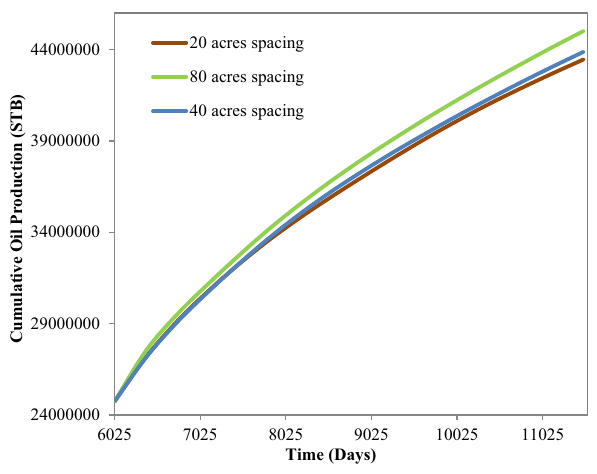
Fig. 13 Cumulative water production versus time for 3 vertical infill wells at different well spacings